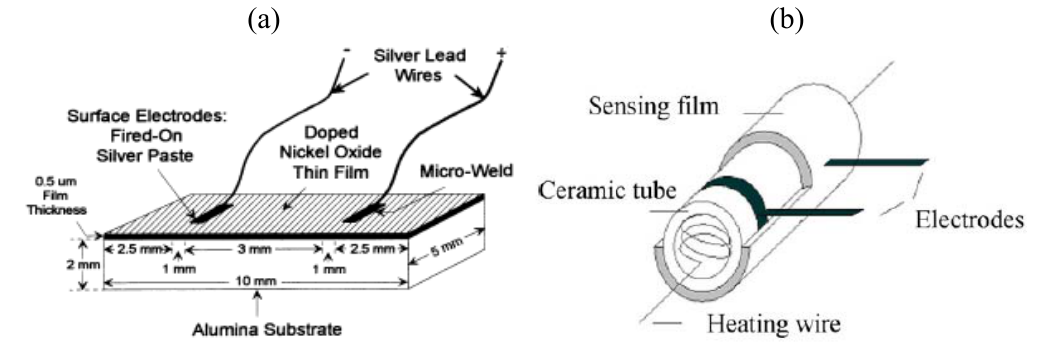
Figure 1. Formaldehyde sensor configurations: (a) ceramic plate structure, reprinted from [27] with the permission from Elsevier and (b) ceramic tube structure, reprinted from [8] with permission from